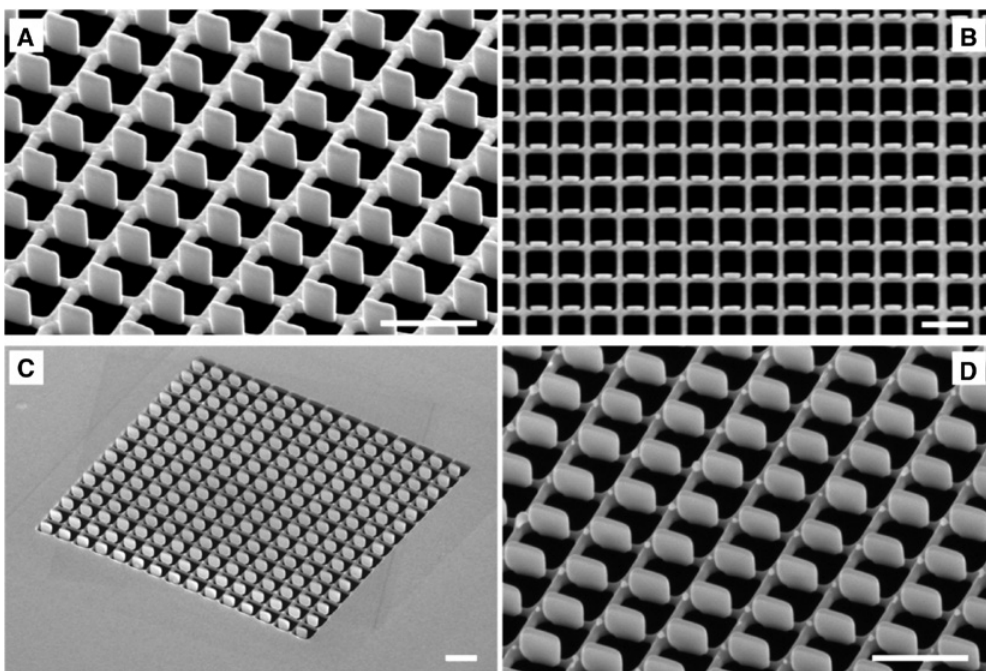
Figure 4: Vertical plate arrays fabricated by tree-type nano-kirigami. (A, B) Side-view and top-view SEM images of vertical plates standing along one edge of the planar metallic hole arrays. (C, D) Side-view SEM images of the same design as in (A, B) but fabricated in an 80-nm gold film deposited on a commercial SiN film window (30 nm thick). Lattice constant: 700 nm. Scale bars: 1 μ